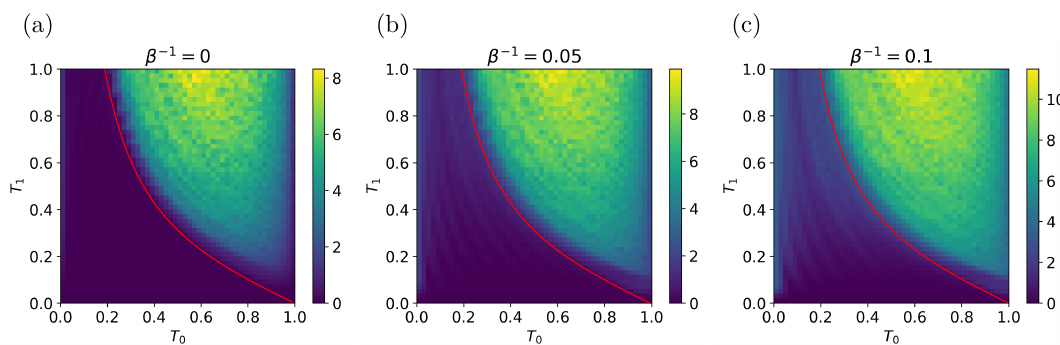
Figure 3: Total energy after 10 cycles as a function of T